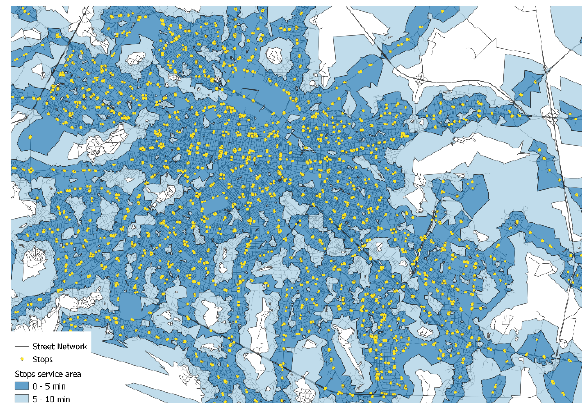
Figure 4. Service area of every public transport stop.